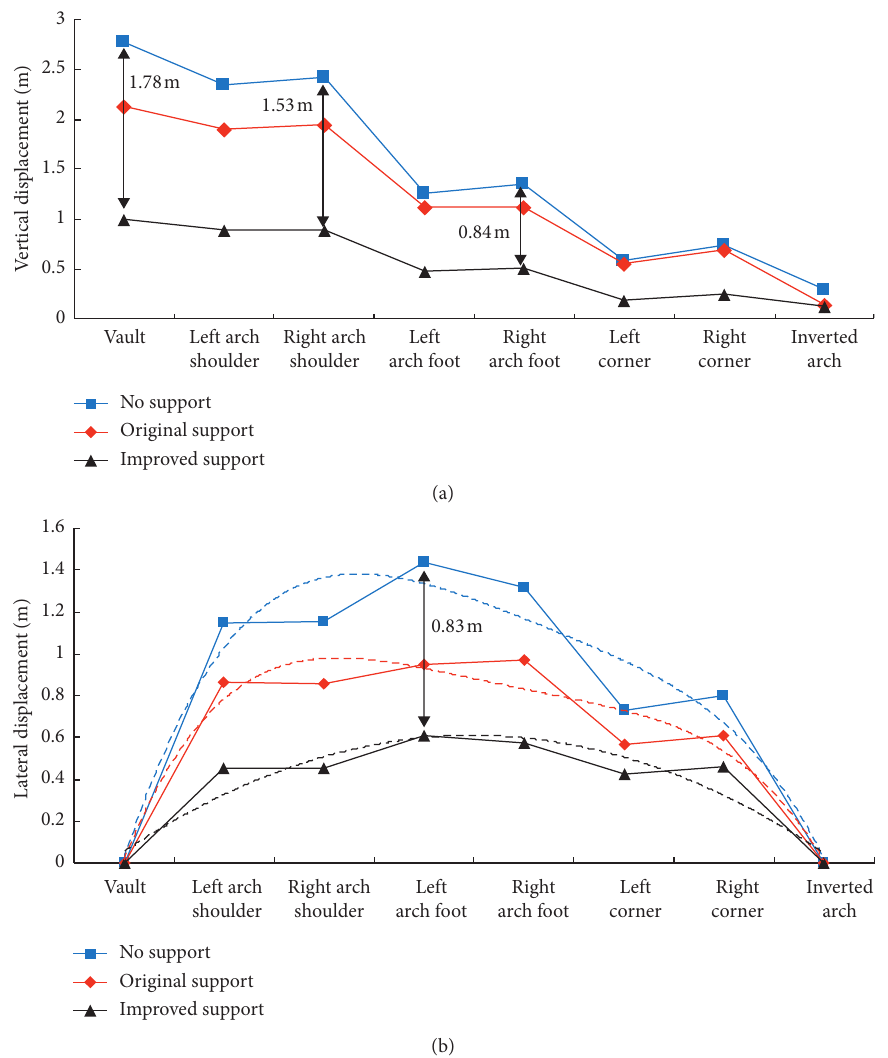
Figure 11: Trend diagram of displacement of each measuring point in the tunnel. (a) Z -direction displacement of each measuring point. (b) X -direction displacement of each measuring point.